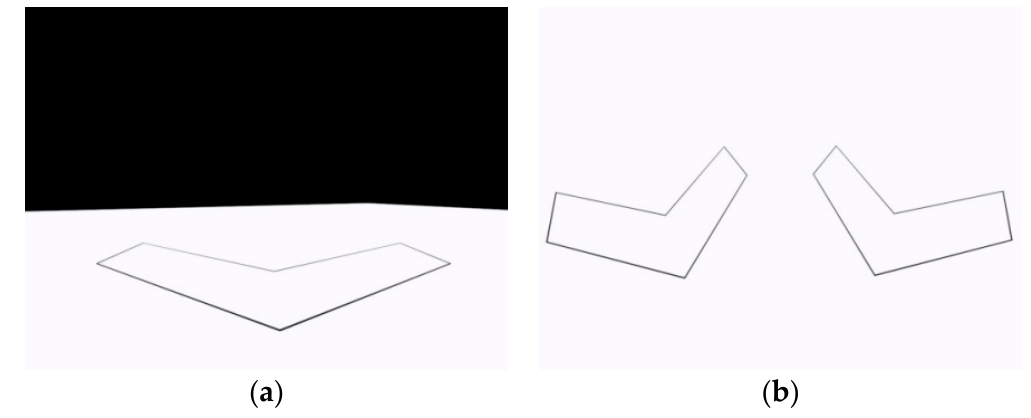
Figure 9. Simulation images: ( a ) Target 1 captured by camera 1; ( b ) Target 2 and Target 3 captured by the auxiliary camera.